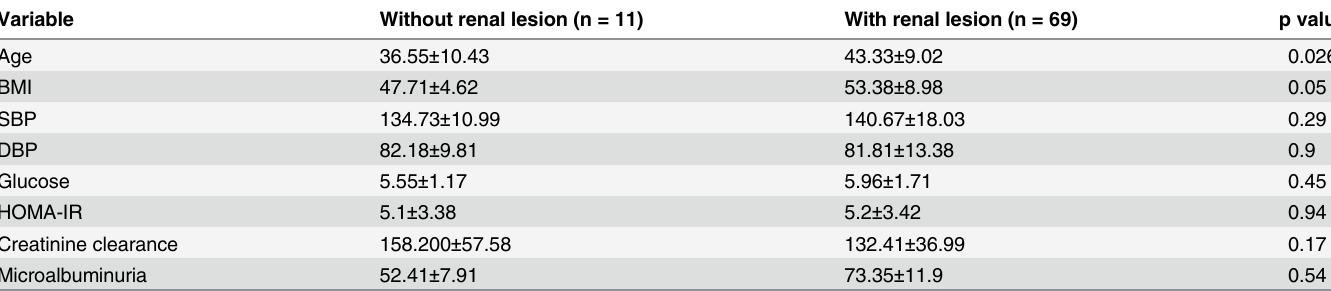
Table 2. Baseline characteristics of the groups with and without renal lesions.